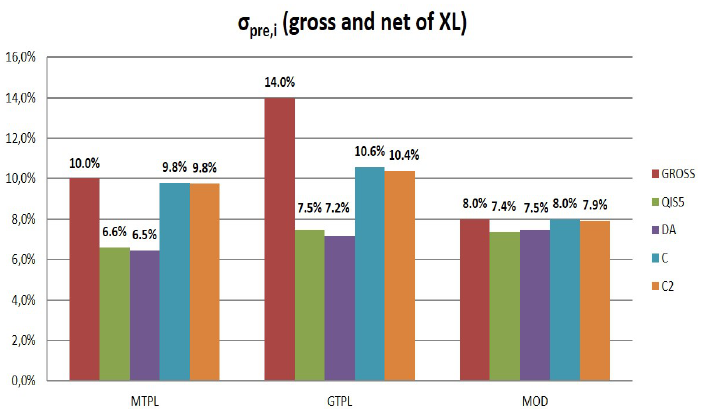
Figure 1. Gross and net values of premium risk volatilities ( σ pre , i